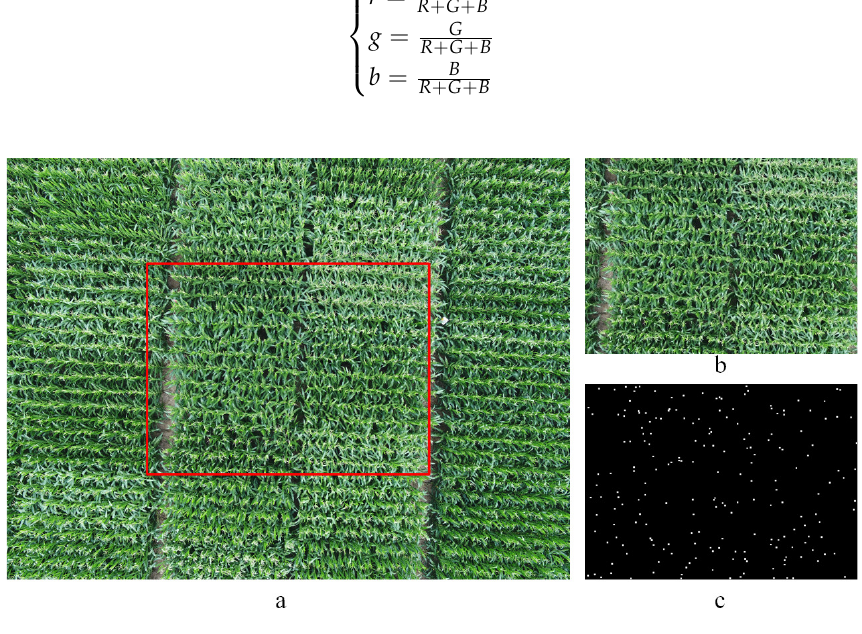
Figure 4. Process of sample acquisition. ( a ) Original image. ( b ) Cropped image. ( c ) Random sample points (white points). Table 1. Classification results under different proportions of tassel